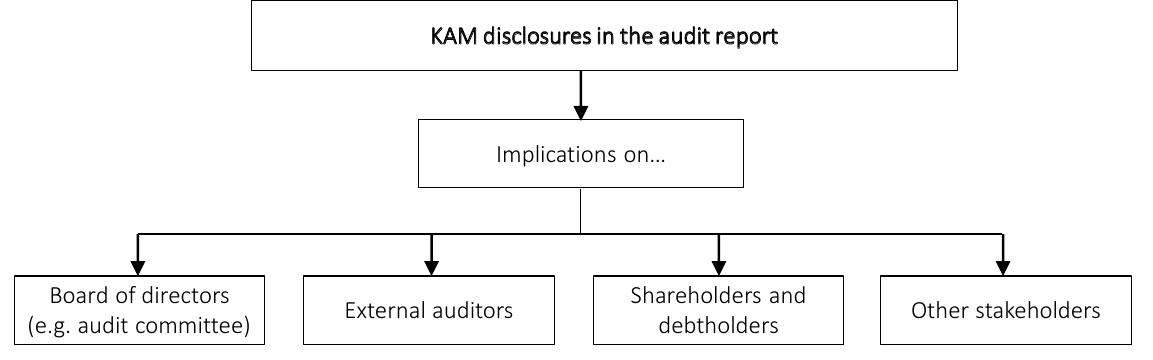
Figure 2. Research